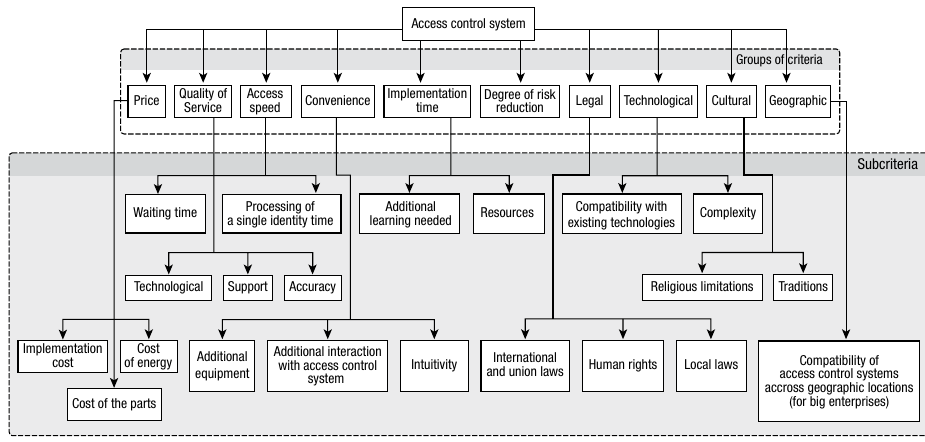
Fig. 6. Criteria tree for access control